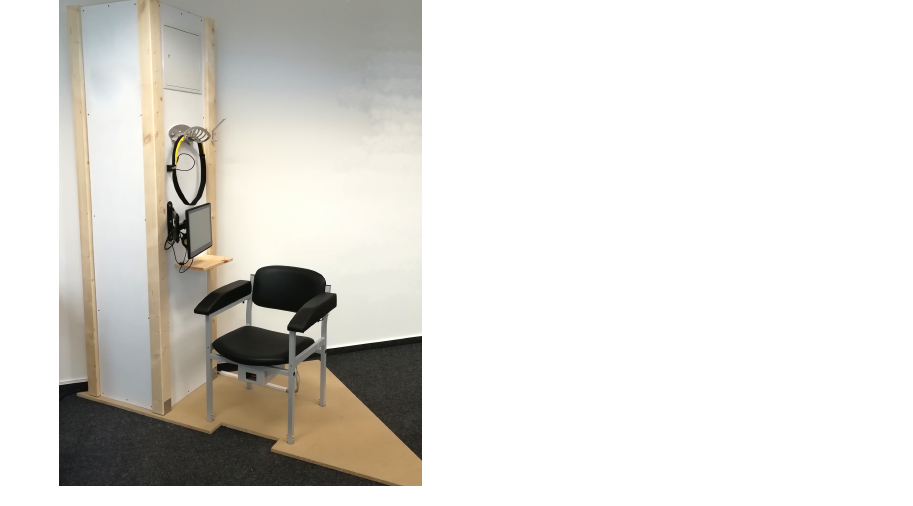
Figure 12. Example of a later USS, where the casing was adjusted for the requirements of a sports